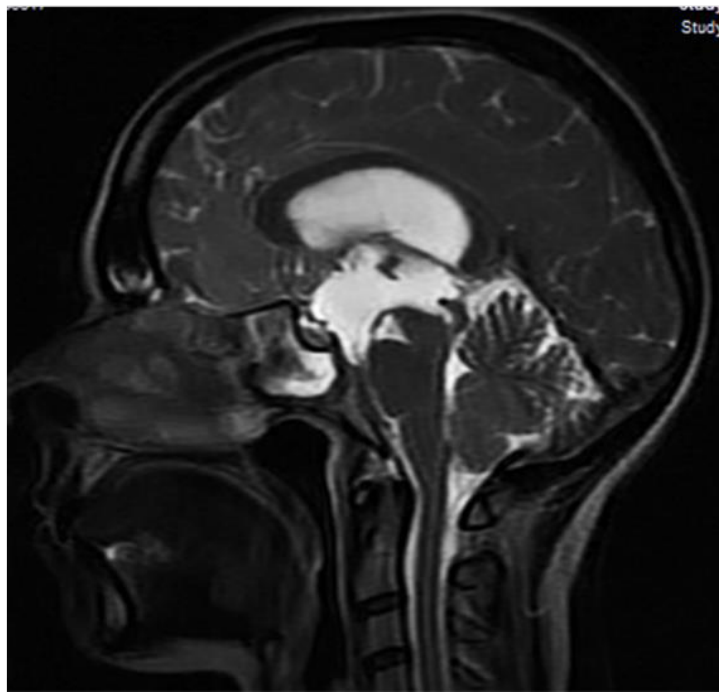
Figure 1. MRI shows Aqueduct